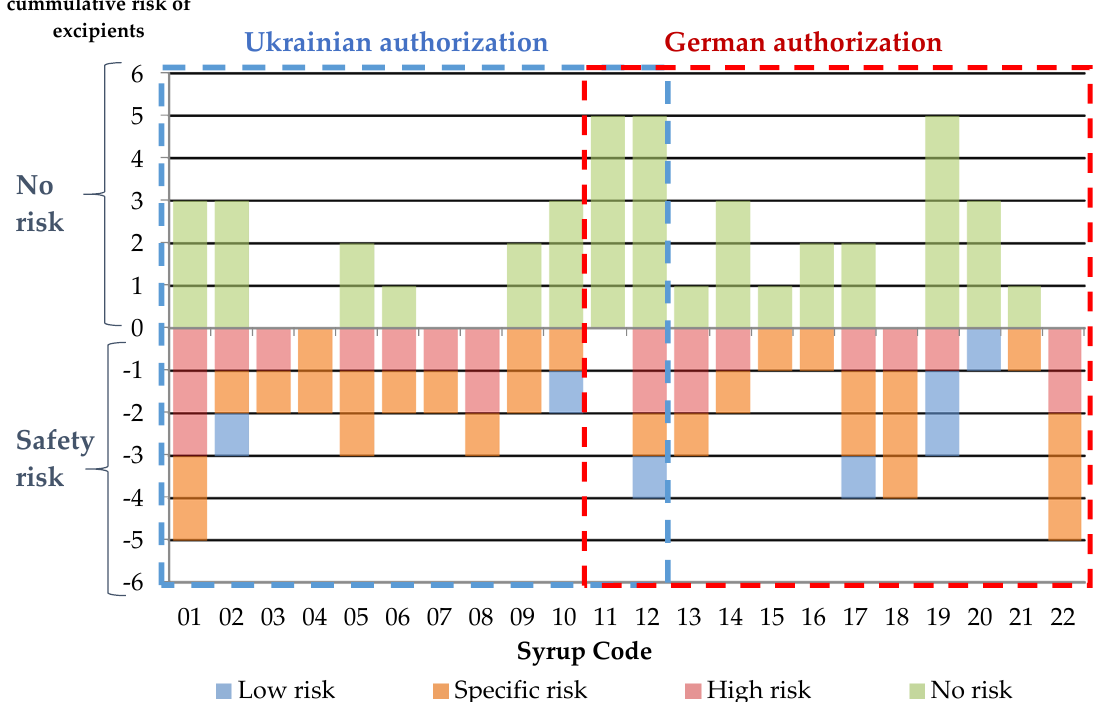
Figure 1. The cumulative safety risk of excipients present in analyzed syrups with Ukrainian and German marketing authorization.